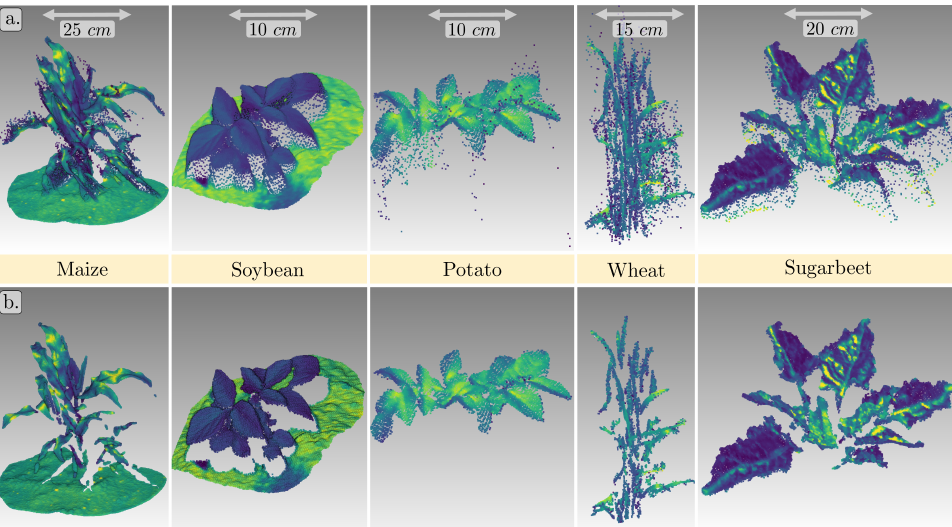
Figure 9. Point clouds of maize, soybean, potato, wheat, and sugar beet before and after mixed pixel removal: ( a ) crop point clouds affected by outliers and mixed pixels; ( b ) point clouds after application of the statistical outlier removal filter; SOR parameter: neighborhood points: k = 20; standard deviation multiplier: q = 0.1.